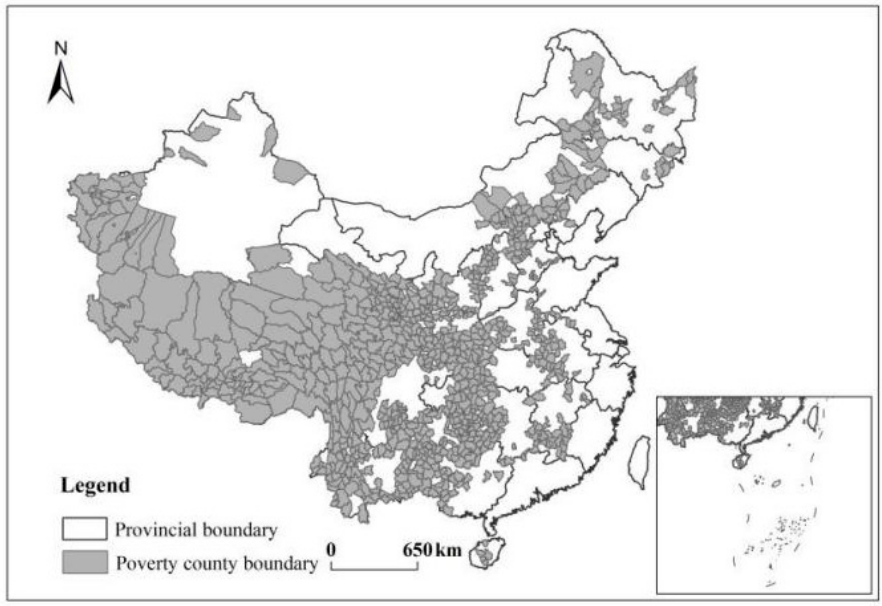
Figure 1. Study area.